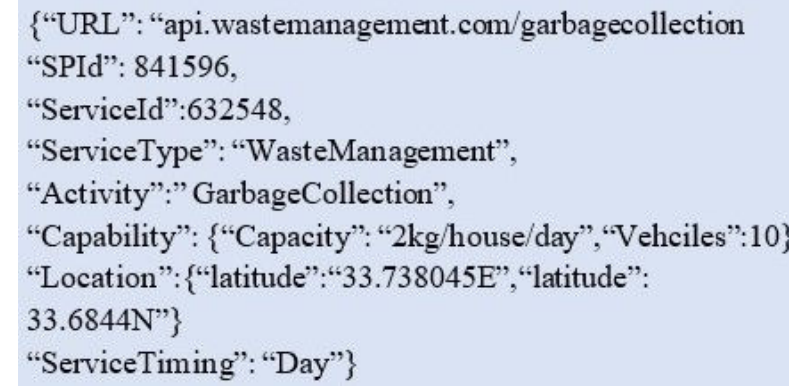
Figure 3. Service modeling at service provider end.